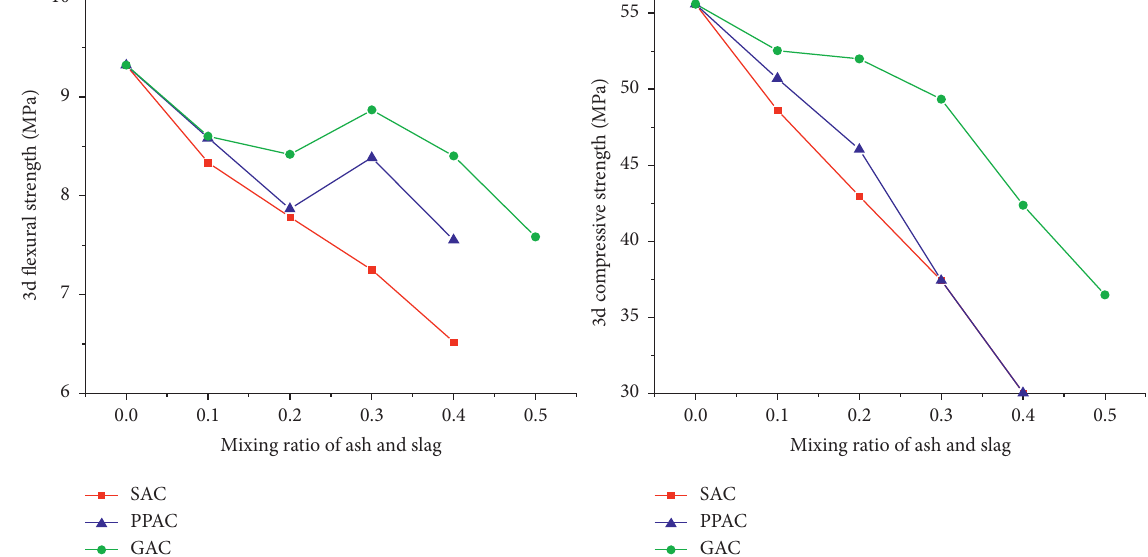
Figure 12: The 28-day strength comparison diagram of mortar with different dosage of